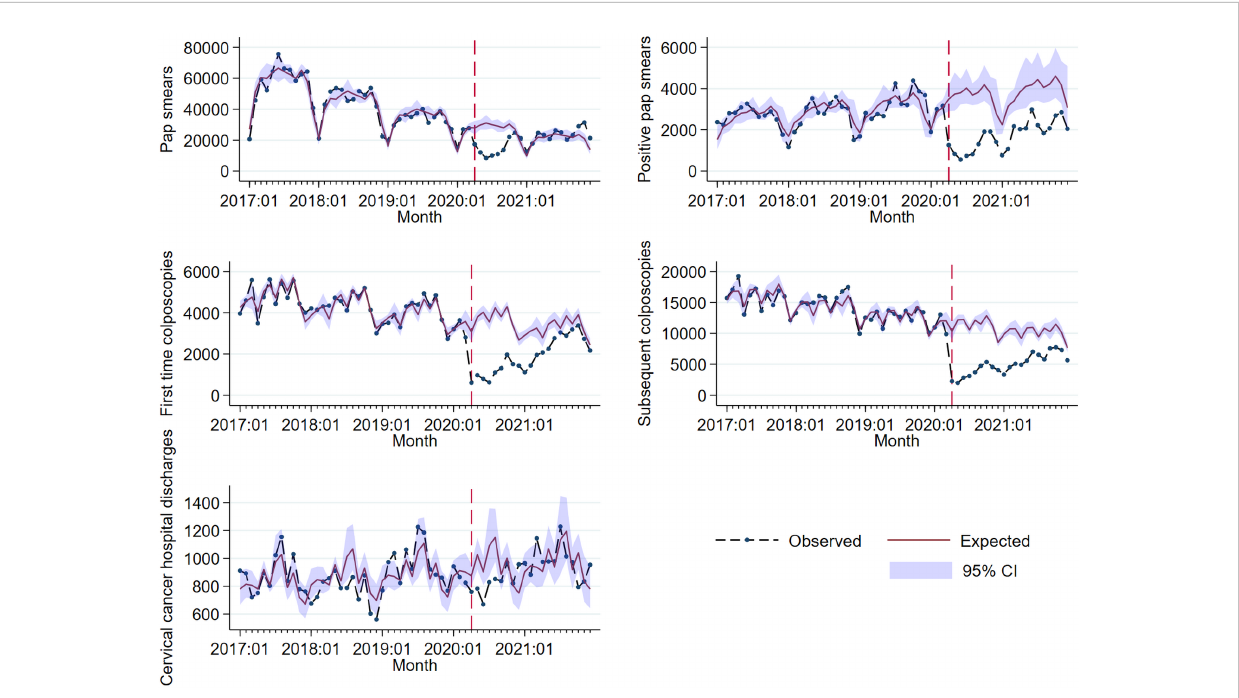
FIGURE 2 Observed and fi tted trends for fi ve process indicators to evaluate disruption of the CC program. Source: Outpatient provided services information system and Hospital discharges. 2017-2021. DGIS. The dashed line marks the start of the pandemic period (April 2020 – December 2021). Expected trends were obtained from Poisson models trained during the pre-pandemic period (January 2017 – March 2020). The linear predictor included a time linear trend and month indicator variables to model seasonality. Standard errors were heteroskedastic and autocorrelation consistent using the Newey-West methodology with two lags. CI, Con fi dence